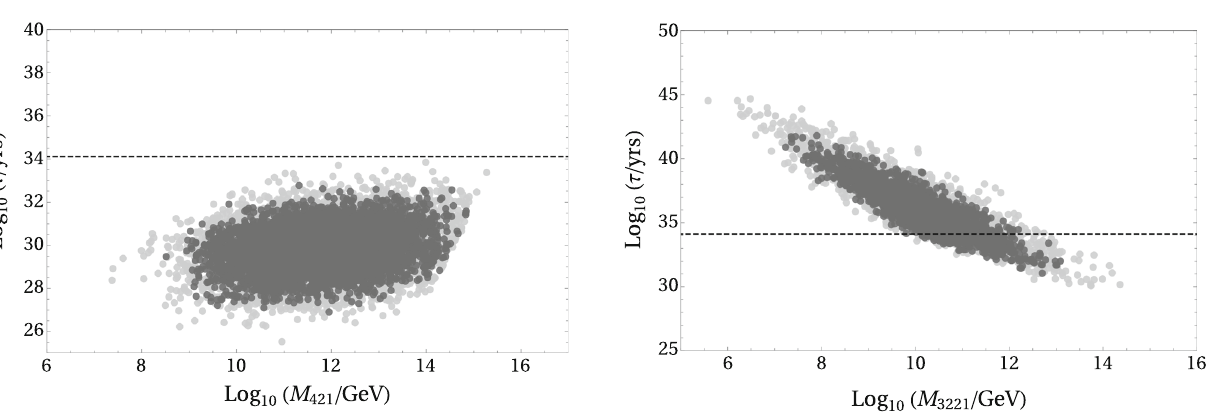
Fig. 9 Impact of possible threshold corrections on the proton lifetime τ in SO ( 10 ) models with intermediate SU ( 4 ) symmetry. The gray dots denote randomized mass spectra with R ∈ [ 1 , 2 ] while the light gray dots denote spectra with R ∈ [ 1 10 dashed line denotes the present bound from Super-Kamiokande [41]